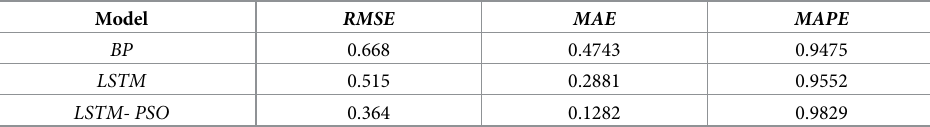
Table 8. Comparison and verification of Different Methods with 96 groups test data for predicting